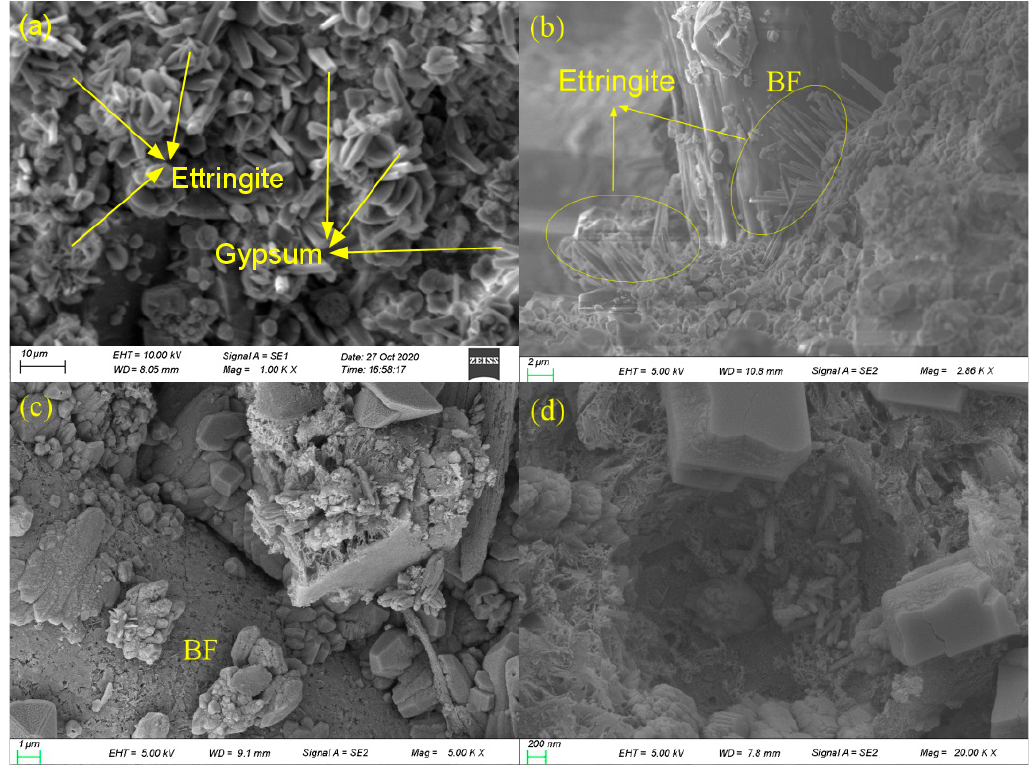
Figure 14. SEM micrographs of specimen BC-0.1 after 180 days of erosion: ( a ) corrosion products; ( b ) and ( c ) BF-ITZ; ( d ) pore with corrosion products.